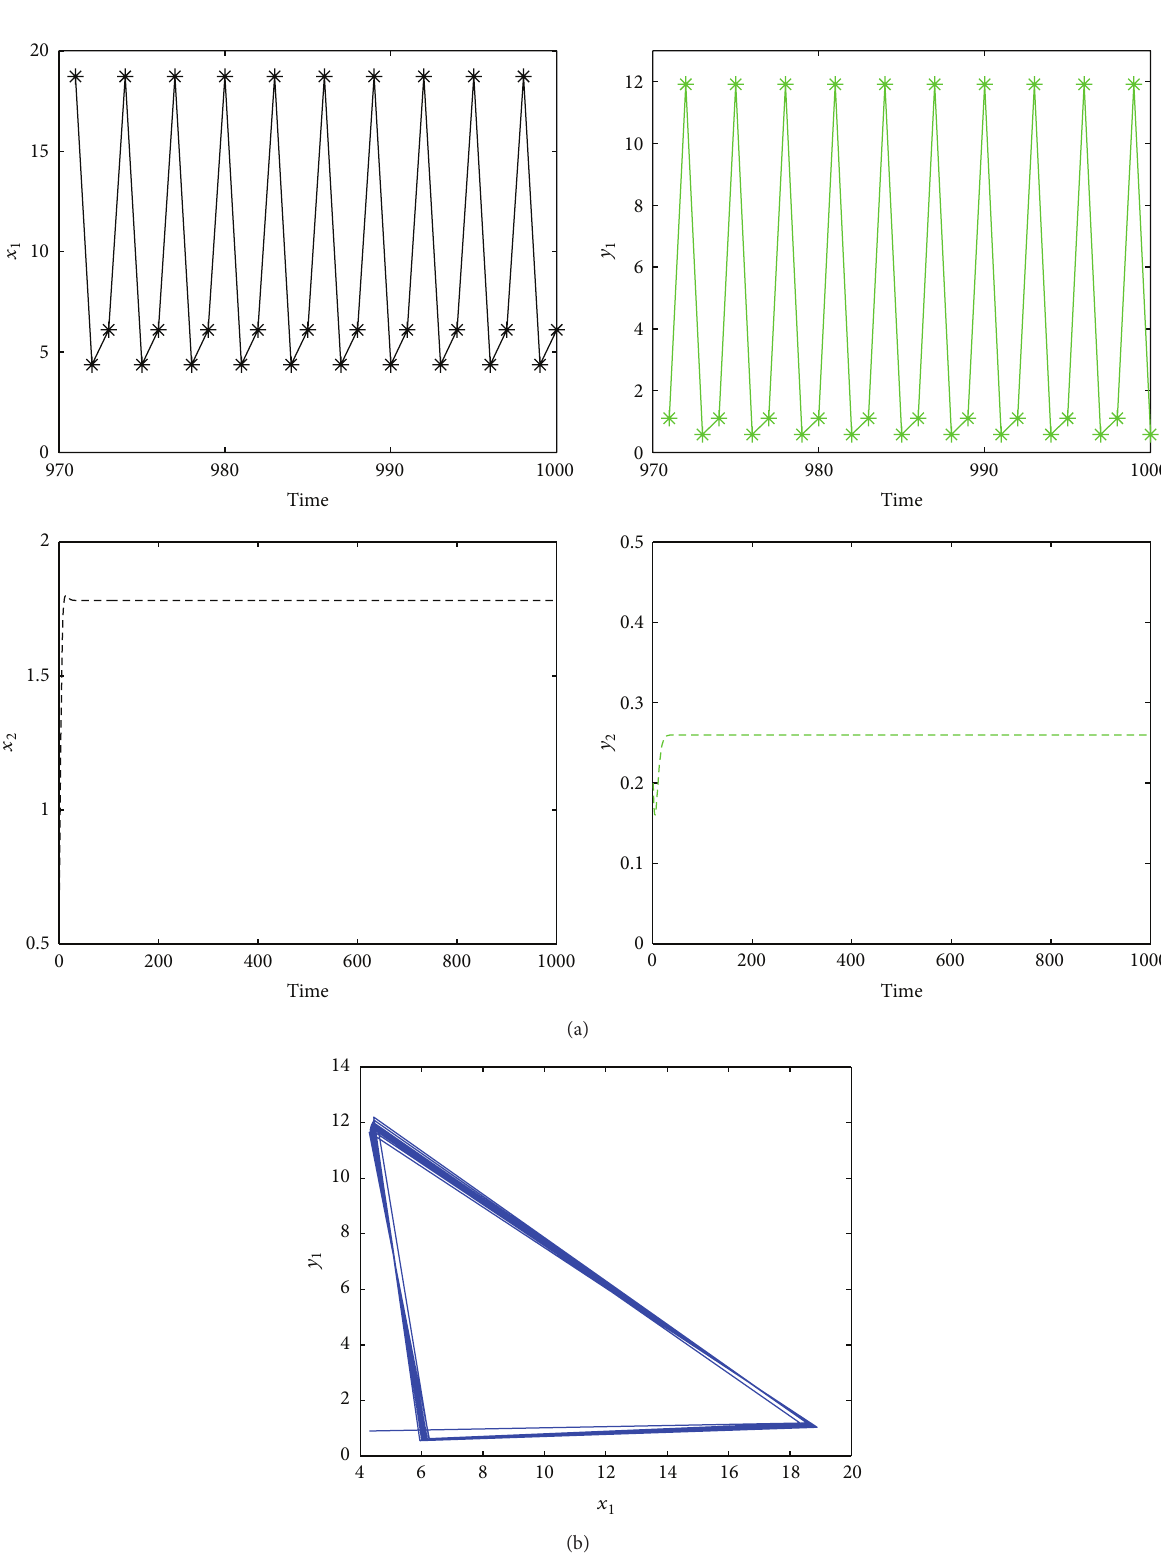
Figure 5: The dynamics of model (44). (a) is the dynamics of (44). It is observed that model (44) is permanent. The subsystem of patch 2 has a stable positive equilibrium, while oscillating population densities for both the prey and the predator are observed in the subsystem of patch 1. (b) is the dynamics of the subsystem of patch 1 illustrated in the phase diagram (𝑥 1 , 𝑦 1 ) . A periodic solution of period 3 is